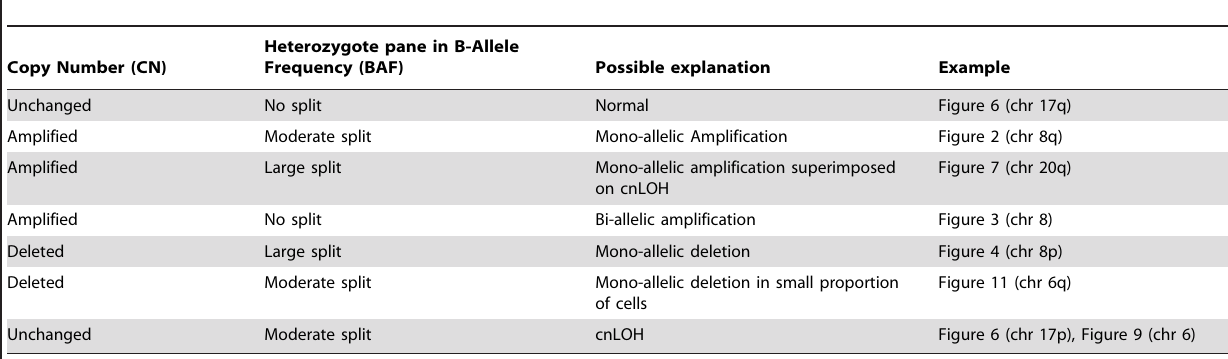
Table 2. Interpretation of CN and BAF in autosomes for possible underlying mechanism of chromosomal abnormality.